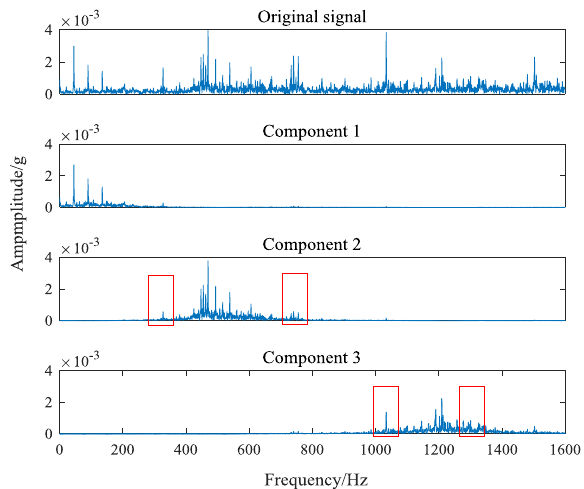
Figure 6. Highly similar vibration signals: wear and root crack.